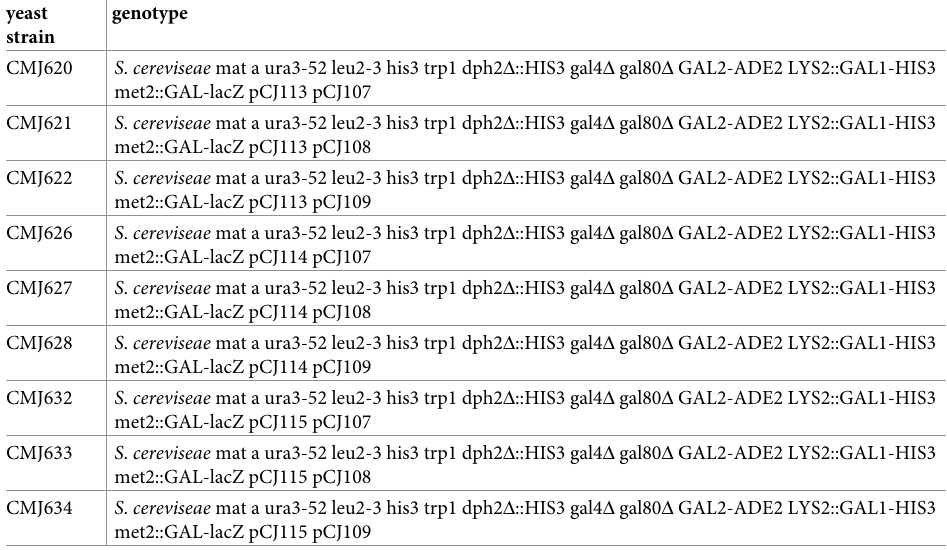
Table 2. Yeast strains